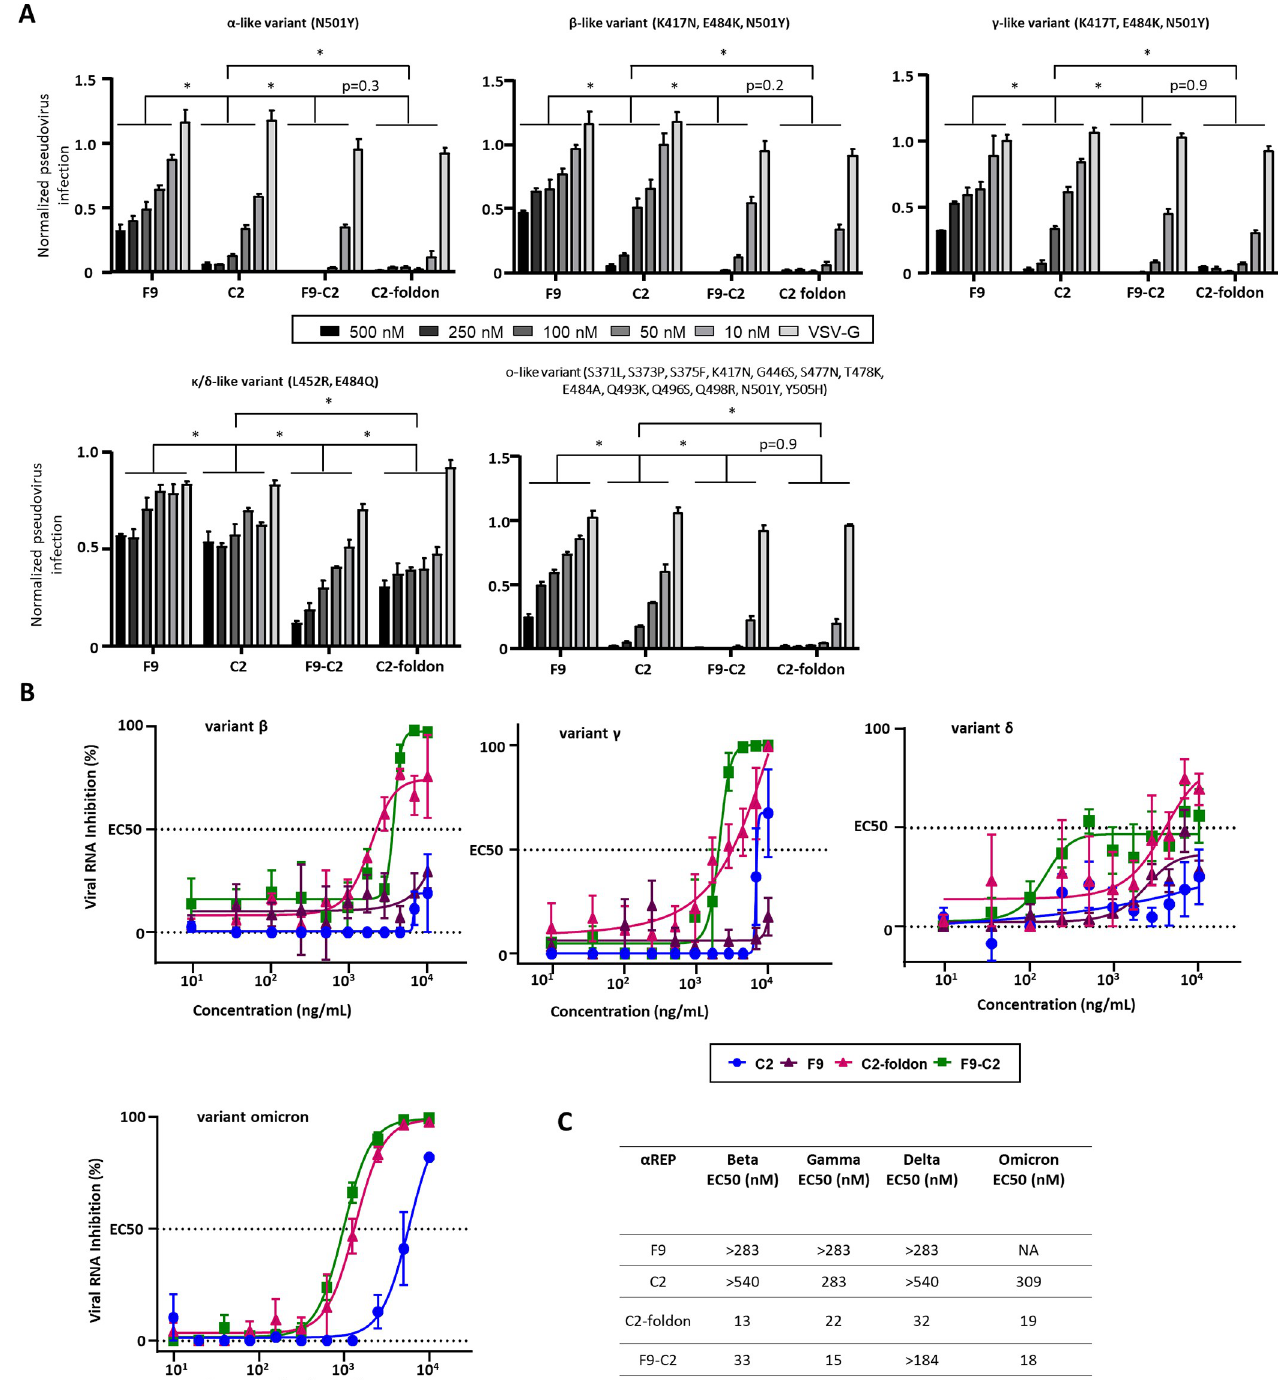
Fig 7. Neutralization activity of the F9-C2 and C2-foldon constructs against SARS-CoV-2 pseudo-typed and virus variants. (A) F9, C2, F9-C2 and C2-foldon were tested for their ability to neutralize four SARS-CoV-2 pseudo-typed RBD mutants. Pseudo-typed VSV-G was incubated with the highest concentration of each α Rep (500 nM) to validate specificity of α Rep neutralization activity (n = 3, mean ± SEM, two-way ANOVA, � P < 0.0001). (B) F9, C2, F9-C2 and C2-foldon were tested for their ability to neutralize authentic SARS-CoV-2 virus variants (beta, gamma, delta and omicron) (n = 3, mean ± SEM). ( C ) Chart listing the EC50 of α Reps and derivates towards variant viruses.